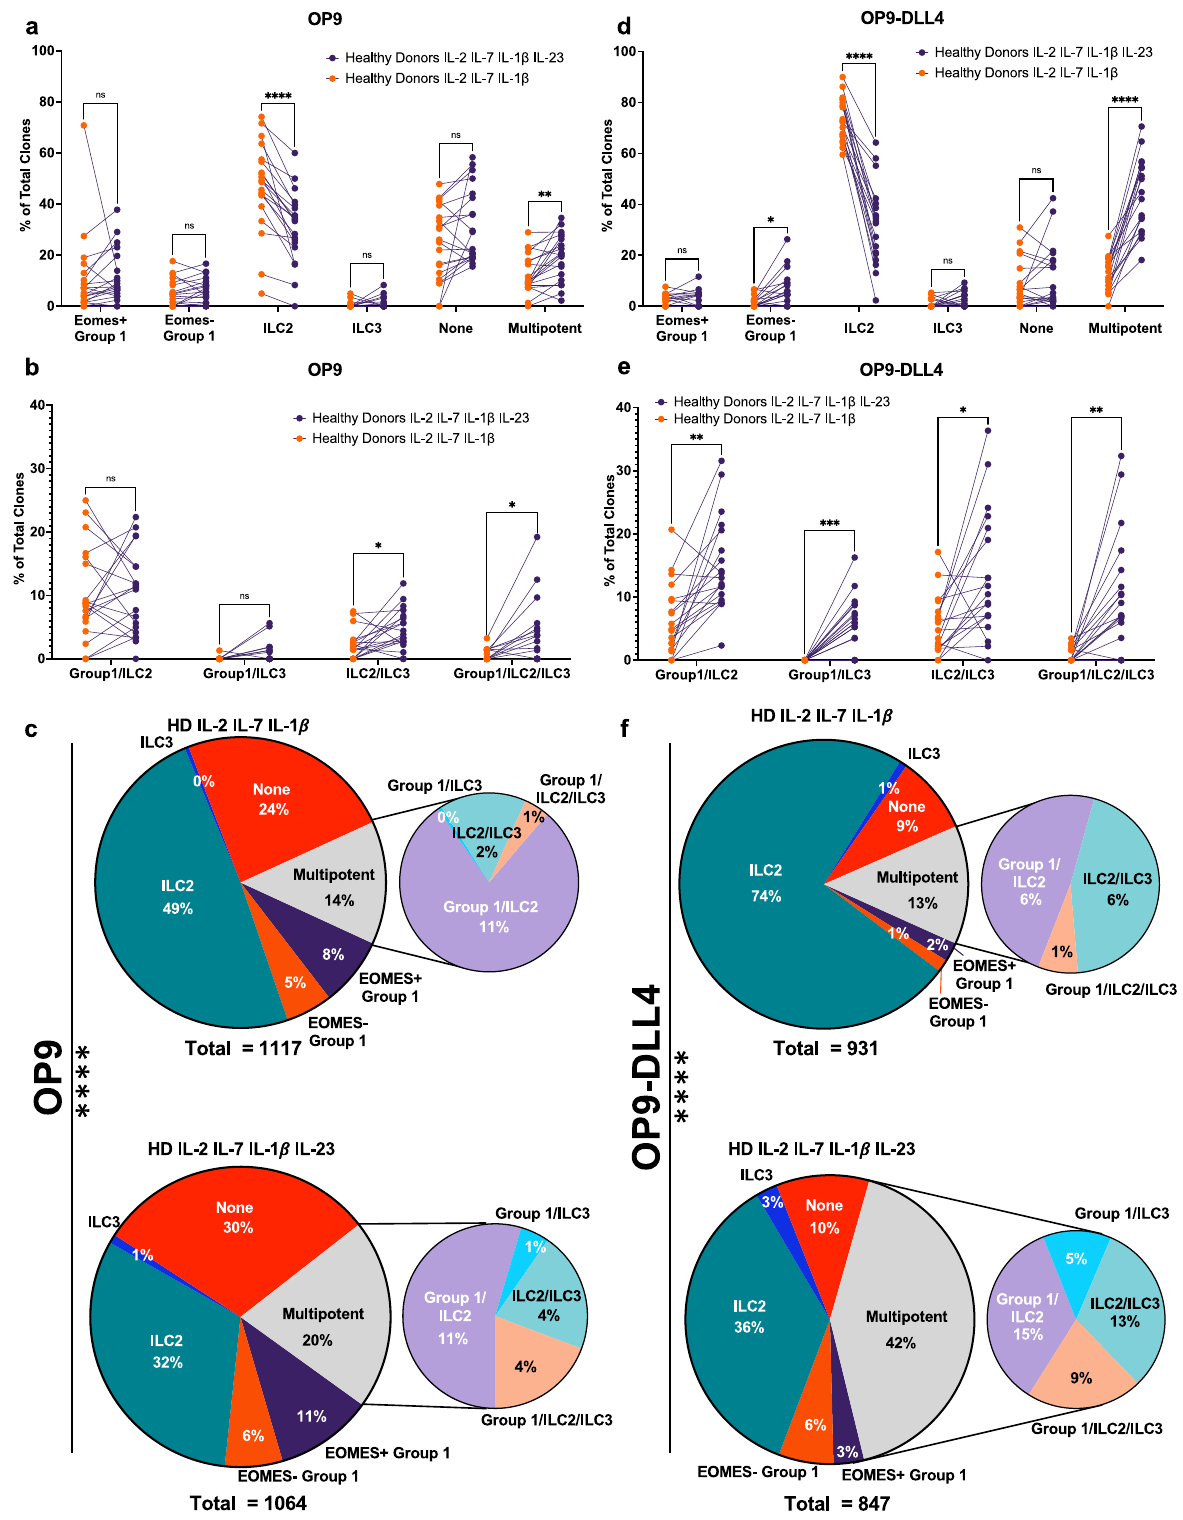
Fig. 5 | Effects of Notch signaling and IL-23 on clonal ILC differentiation from bloodILCP. HumanILCPcloningonOP9( n =20)orOP9-DLL4( n =19)stromawith (purplecircles)orwithout(orangecircles)IL-23supplementation. a Frequenciesof unipotent (EOMES+ILC1, EOMES-ILC1, ILC2, ILC3, None) and total multipotent clones per individual healthy donor, b Frequencies of types of multipotent clones and c Overall distributions of clones grown in the presence or absence of IL-23 on OP9stroma. d Frequenciesofunipotentandtotalmultipotentclonesperindividual healthy donor, e Frequencies of types of multipotent clones and f Overall